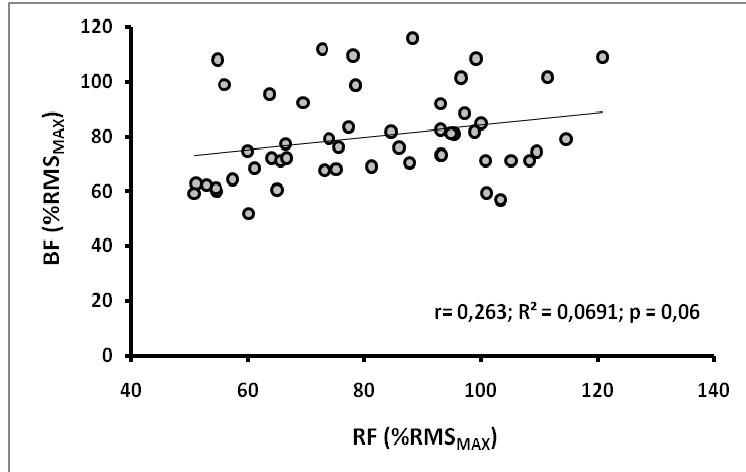
Figura 4- Correlação entre a atividade EMG dos músculos RF e BF de cada sujeito, representada pelos valores médios de RMS de cada período durante o protocolo de saltos.